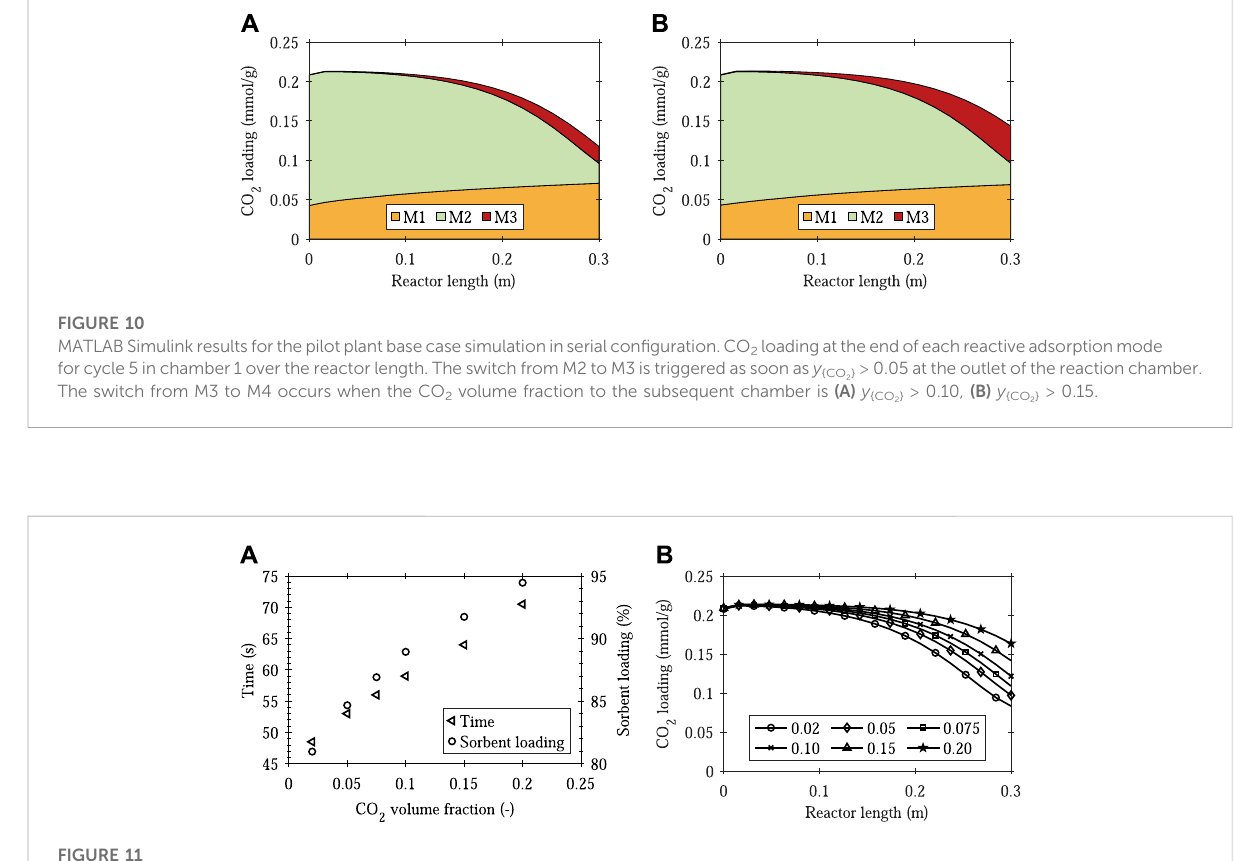
thresholds(switchM2toM4)insinglestagecon fi guration. (A) 2 }